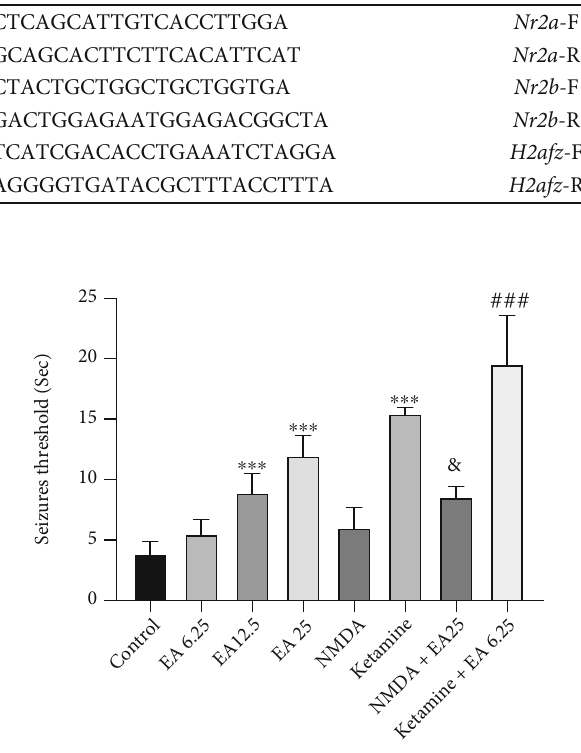
Figure 1: Seizure threshold (second) in the experimental groups. Data are reported as mean ± standard deviation from 8 animals and statistically analyzed by one-way ANOVA and Tukey post hoc test. ∗∗∗ P < 0 : 001 in comparison to the control group (saline- treated), ### P < 0 : 001 in comparison to the group that received EA at a dose of 6.25mg/kg, and & P < 0 : 05 in comparison to the group that received EA at a dose of 25 mg/kg. EA: ellagic